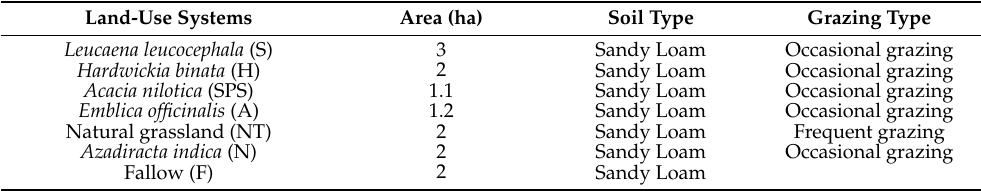
Table 1. The details of experimental site. Land-Use Systems Area (ha) Soil Type Grazing Type